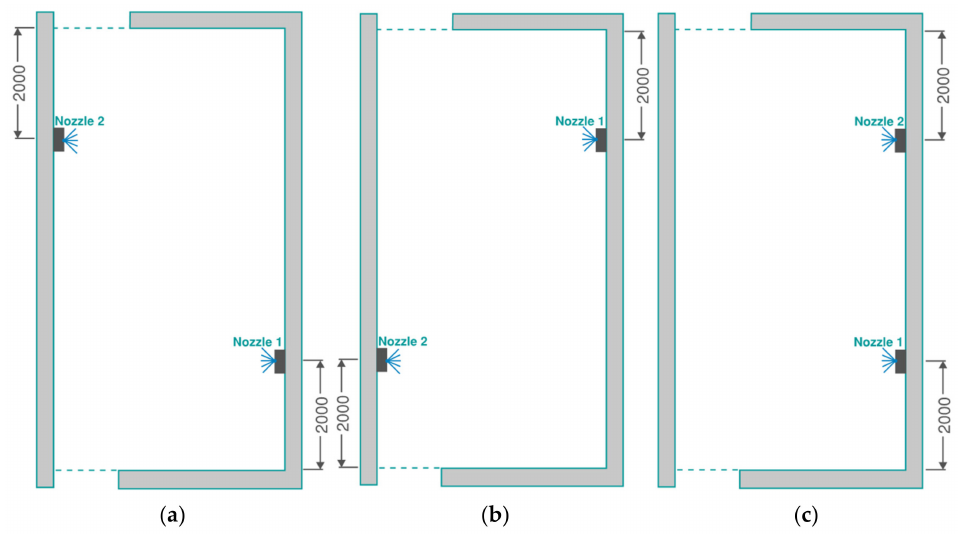
Figure 6. Nozzle arrangements for the tests: ( a ) arrangement 1 (A-01 to A-04); ( b ) arrangement 2 (A-05 to A-08); and ( c ) arrangement 3 (A-09 to A-11). All dimensions in